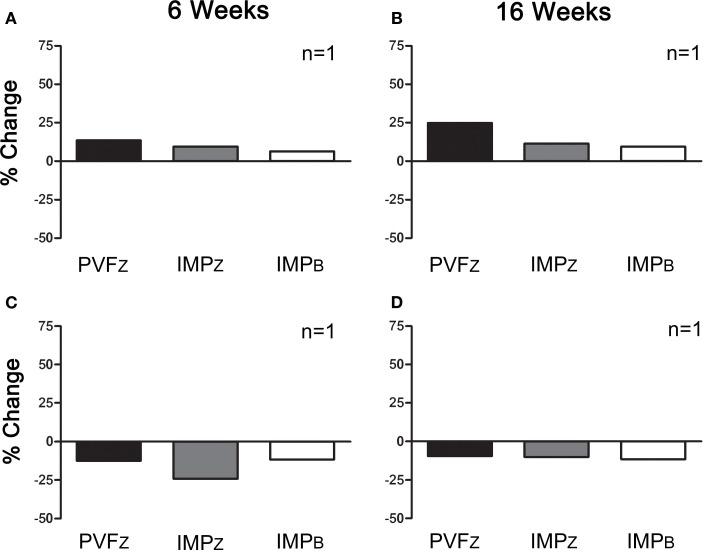
Percent change (mean ± SD) in PVFZ, IMPZ, and IMPB of the affected limb for horses that did not respond to IAA and (A) responded to PRP after 6 weeks, (B) responded to PRP after 16 weeks, (C) did not respond to PRP after 6 weeks, and (D) did not respond to PRP after 16 weeks.